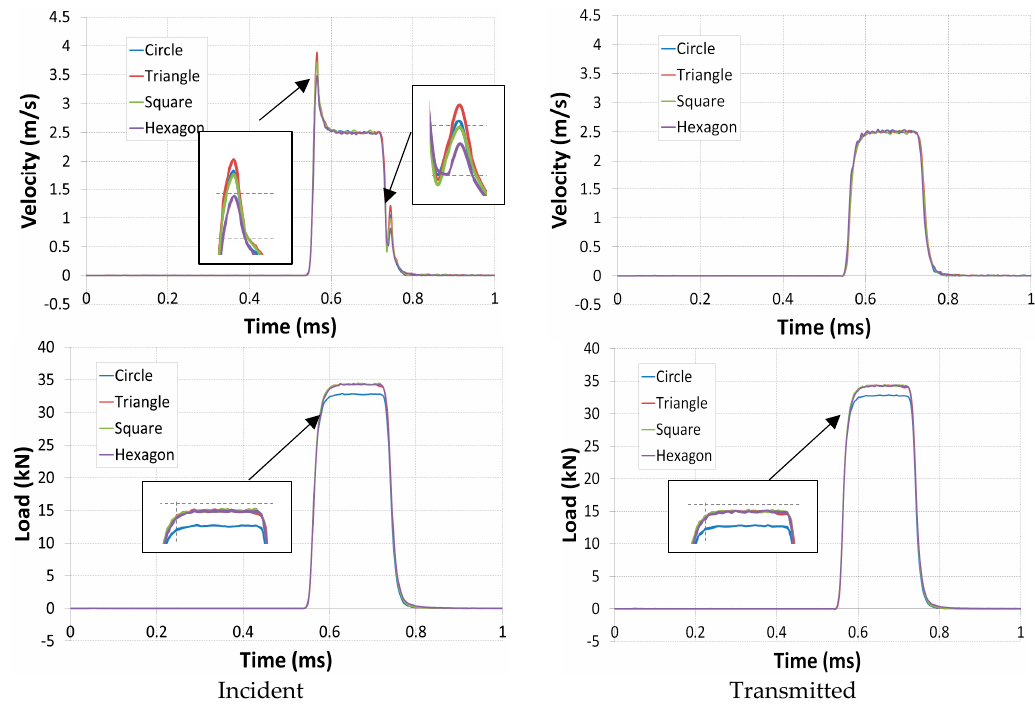
Figure 11. Dynamic compression test parameters with different bar systems.